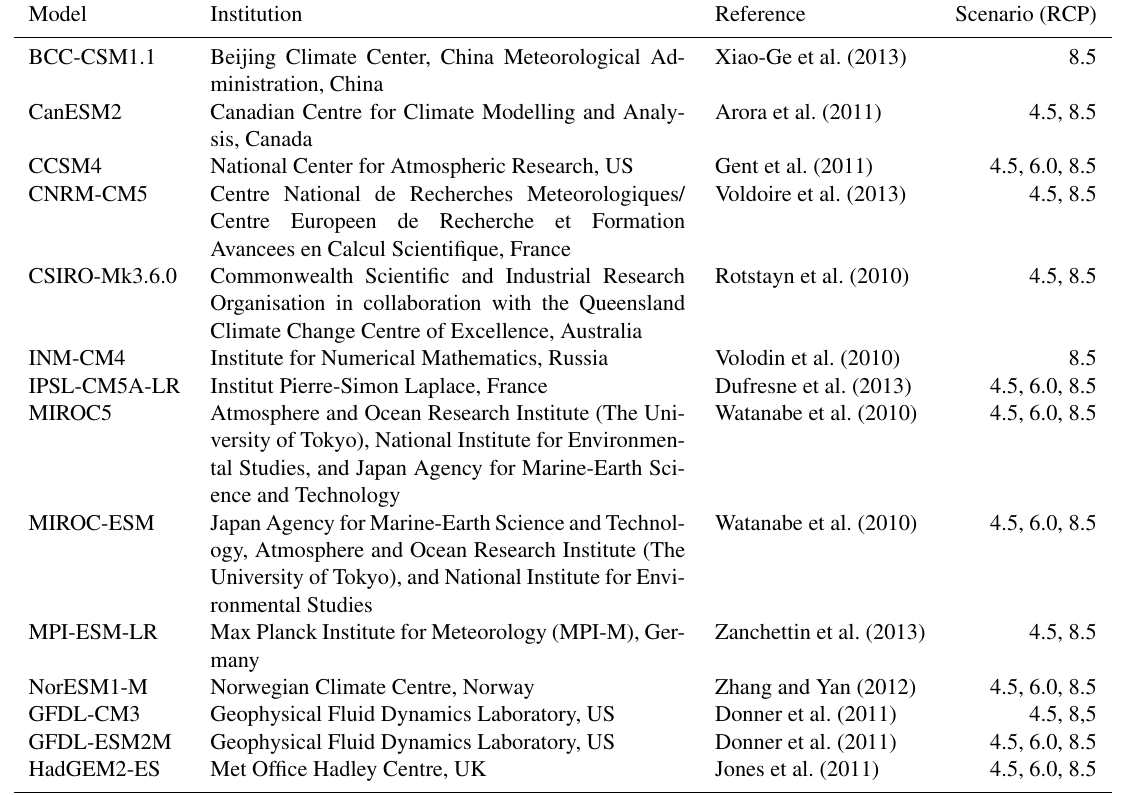
Table 2. CMIP5 GCM models used in this study, including the respective RCP scenario used.